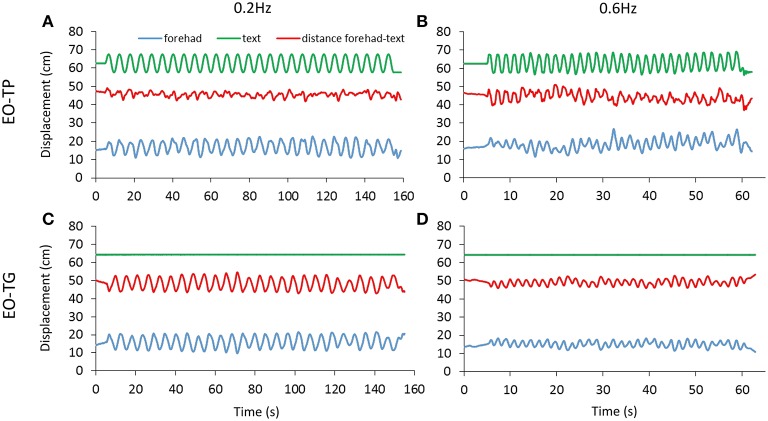
Head-text distance. The distance (red trace) between the marker on the forehead (blue trace) and the marker on the text page (green trace) was measured under EO-TP (A,B) and EO-TG (C,D) conditions for both translation frequencies (0.2 Hz left, 0.6 Hz right). The traces of a representative subject are reported. The mean distance between head and text was about 50 cm under both conditions. Increasing values in the ordinate for the forehead and text displacement traces indicate forward movement.